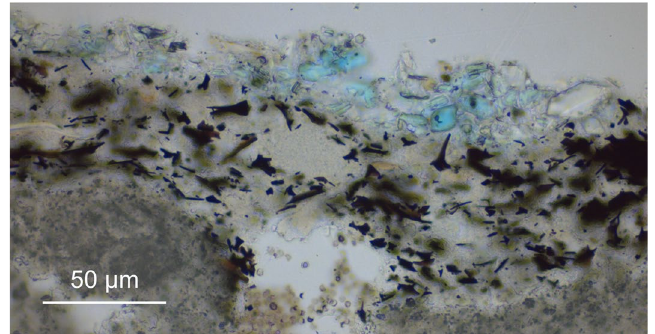
Figure 1. Micrograph of a polished thin section of the Egyptian blue paint layer and underpainting acquired with transmitted light and parallel